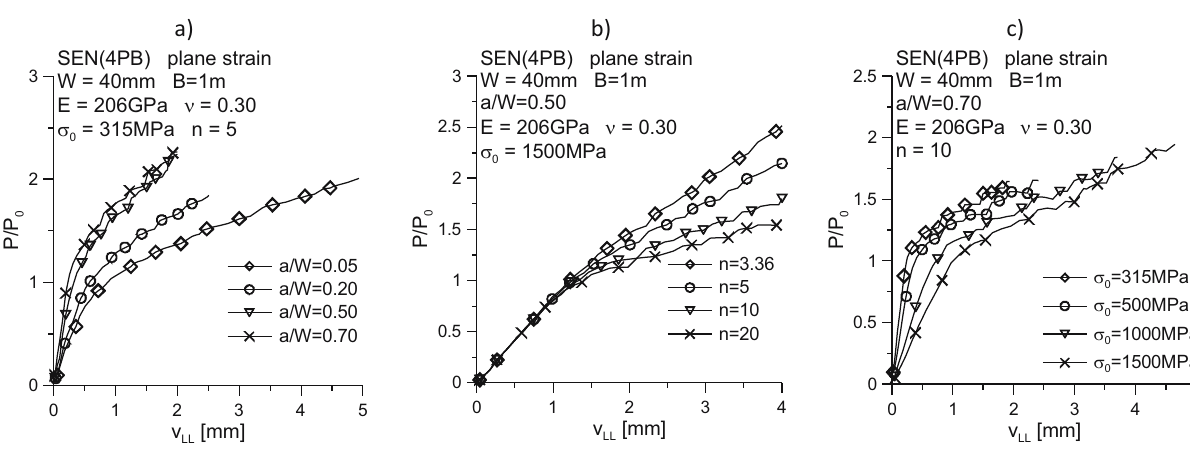
Figure 14: In fl uence of the relative crack length a / W ( a ) , the strain hardening exponent n ( b ) , and the yield point σ 0 ( c ) on the P / P 0 = f ( v LL ) curves for SEN ( 4PB )